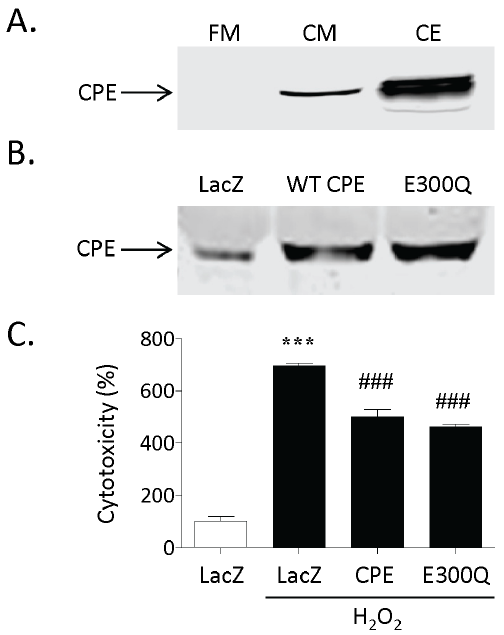
Figure 1. CPE containing conditioned medium protects against H 2 O 2 -induced cytotoxicity in primary cultured rat hippocam- pal neurons. A) Western blot showing the presence of endogenous CPE in the cell lysate (CE) and conditioned medium (CM) of hippocampal neurons. No signal was obtained from the non- conditioned or fresh medium (FM). B) Western blot showing CPE protein in conditioned medium from primary hippocampal neurons transduced with adenovirus harboring LacZ and WT or E300Q CPE constructs. C) Bar graphs showing LDH activity, as an indicator of cellular cytotoxicity, in the culture media of hippocampal neurons treated with and without H 2 O 2 . Note the increased cytotoxicity after H 2 O 2 treatment (LacZ/H 2 O 2 ) compared to control cells (LacZ) that was significantly attenuated by the presence of either WT (CPE/H 2 O 2 ) or E300Q (E300Q/H 2 O 2 ) CPE. Students t test, n=4, ***p , 0.001 compared to LacZ control; ### p , 0.001, compared to LacZ/H 2 O 2